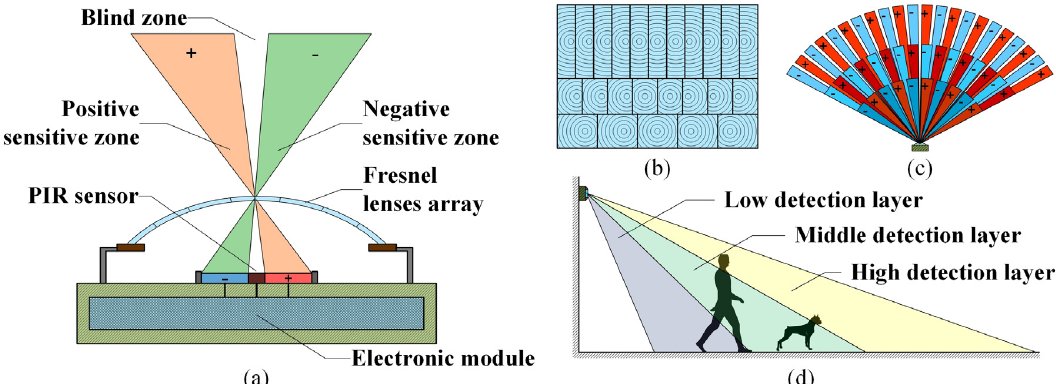
Figure 1. ( a ) Structure of a common PIR detector; ( b ) layout of the Fresnel lenses array; ( c ) top view of the distribution of the SZs and NZs in each detection layer, where the sectors labeled by “+” indicate the PSZs, those labeled by “ − “ indicate the NSZs and the gaps between the PSZs and NSZs indicate the BZs; ( d ) lateral view of the distribution of the three detector layers.